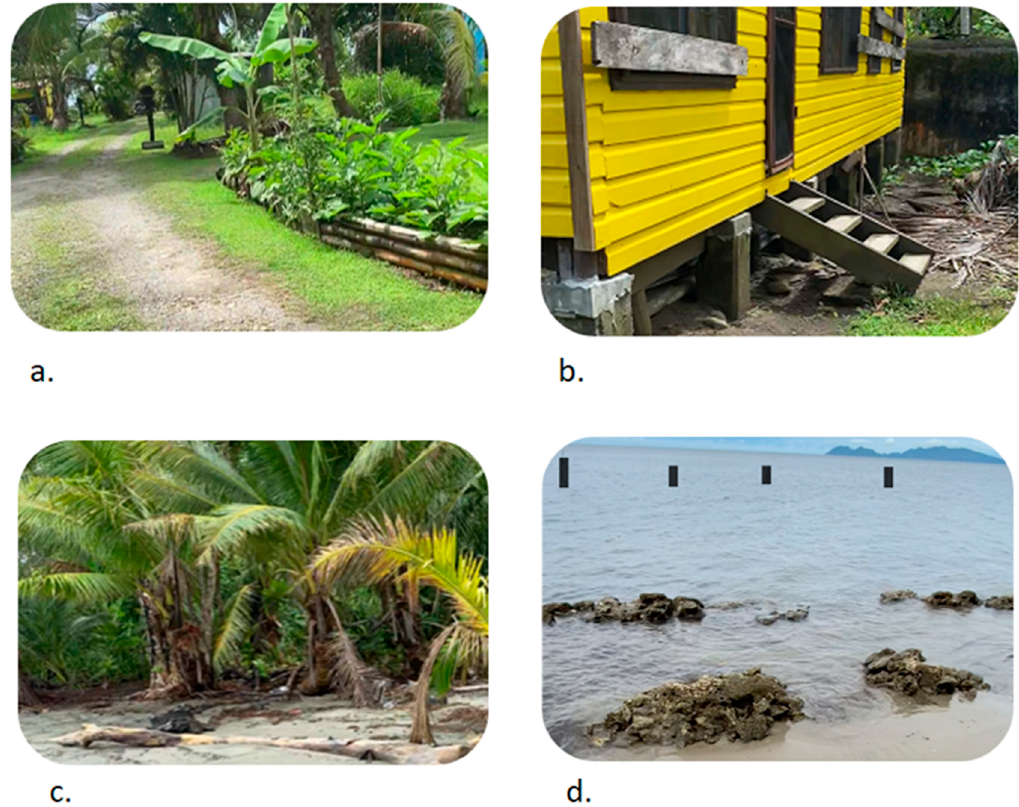
Figure 4. Images of adapting in place: ( a ) Innovative salt-tolerant farming; ( b ) Climate proofing infrastructure; ( c ) Coconut trees planted for coastal protection; and ( d ) Hard defenses—markings of a proposed sea wall by the Government of Fiji in 2020. Photo credit (Yee, 2021). Table 2. Adaptation to coastal hazards at the household, community, and government level.